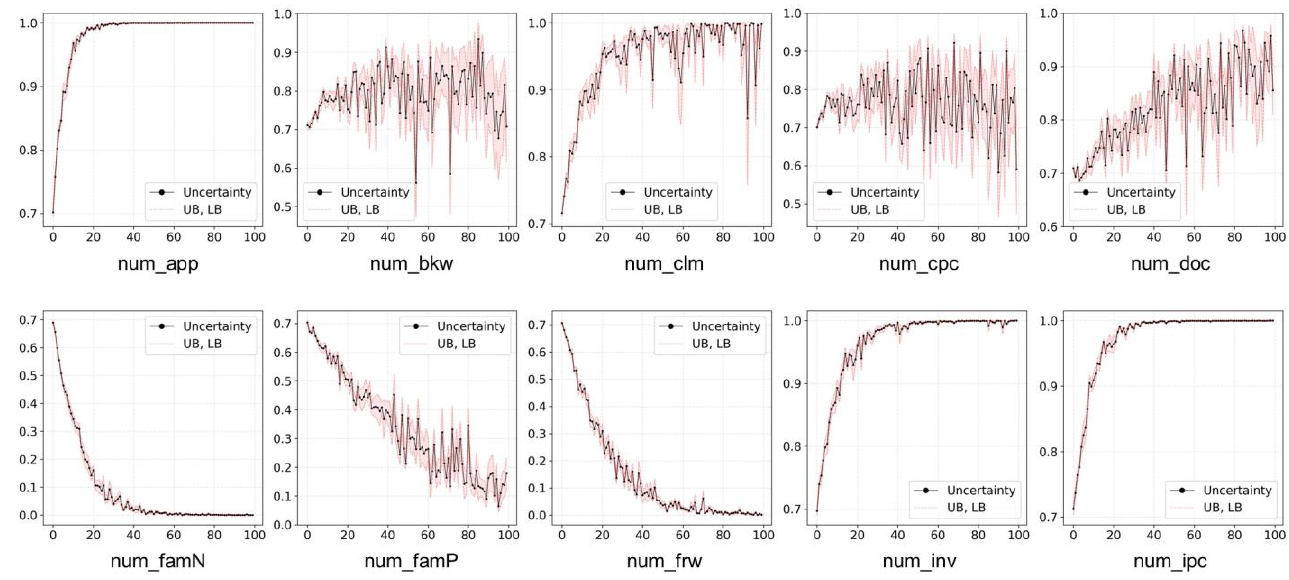
Figure 5. Results of a factor ablation trial. The black line is the average of the uncertainty, and the red part represents the upper and lower bounds of the uncertainty.